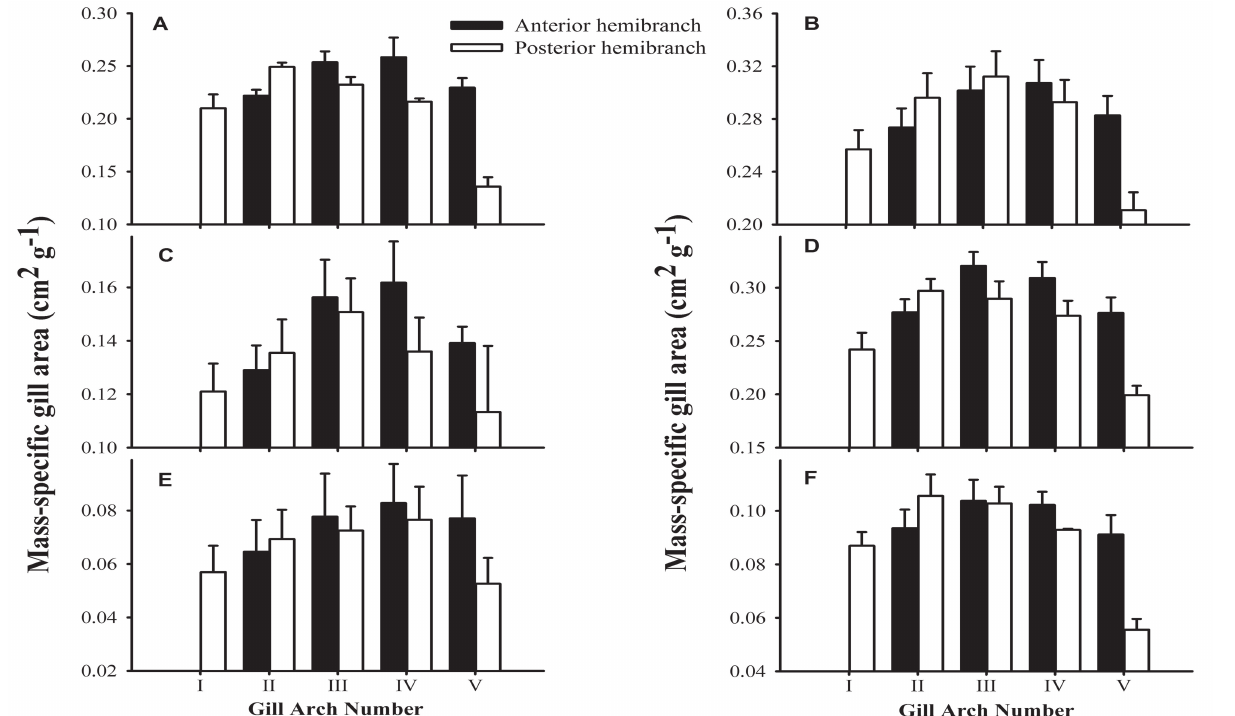
Fig. 3 . Mass-specific gill area of the anterior and posterior hemibranchs of the gill arches in different potamotrygonid embryos: (A) Potamotrygon orbignyi ; (B) Potamotrygon sp.; (C) Potamotrygon motoro (from Negro River); (D) Potamotrygon motoro (from Solimões River); (E) Plesiotrygon iwamae ; (F) Paratrygon